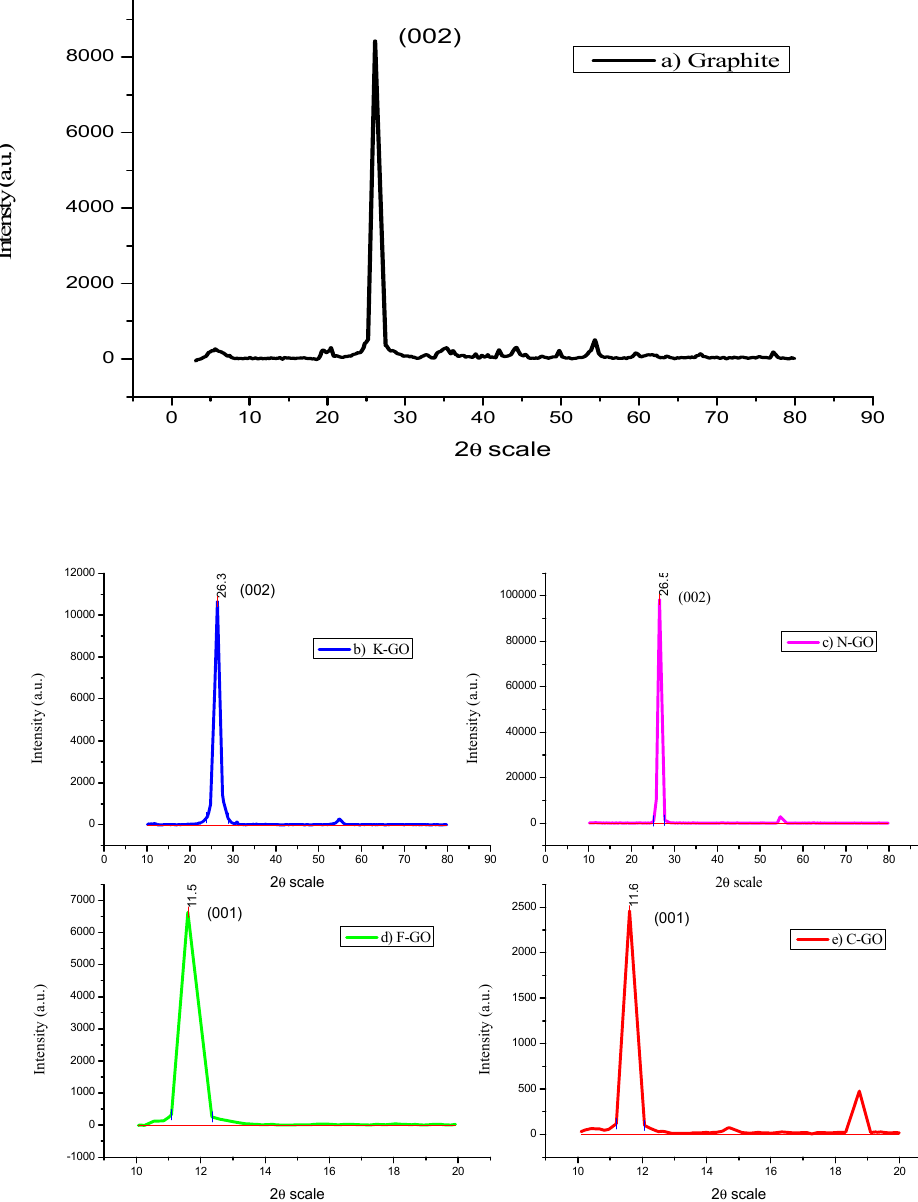
Figure 1. XRD images of graphite ( a ), K–GO ( b ), N–GO ( c ), F–GO ( d ), and C–GO ( e ).